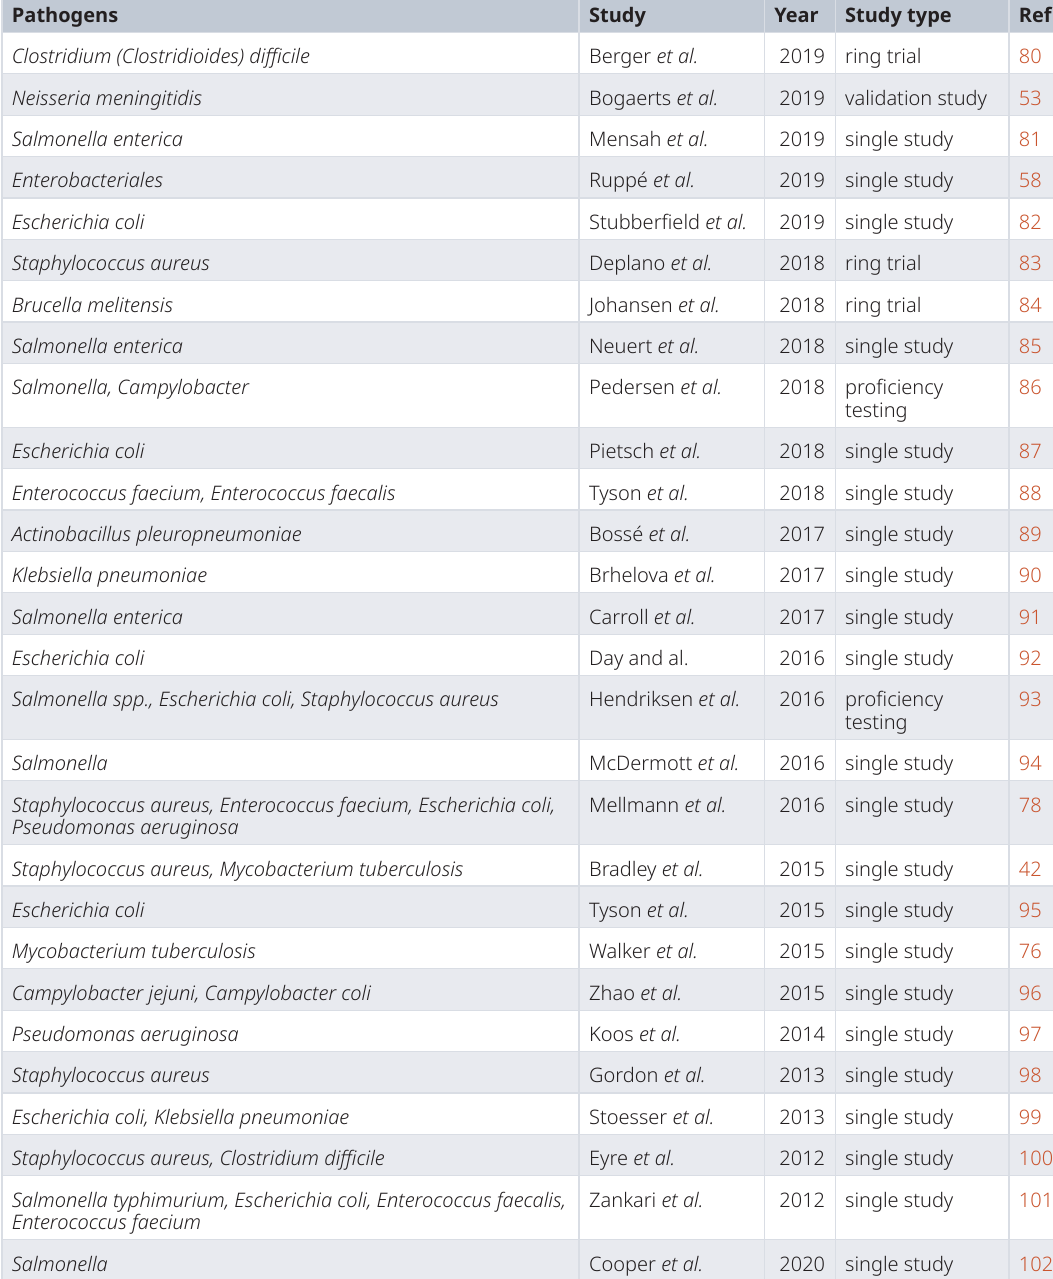
Table 3. Non-exhaustive list of sample studies to be analysed for the availability of FAIR raw reads data, to include in the benchmark resource.